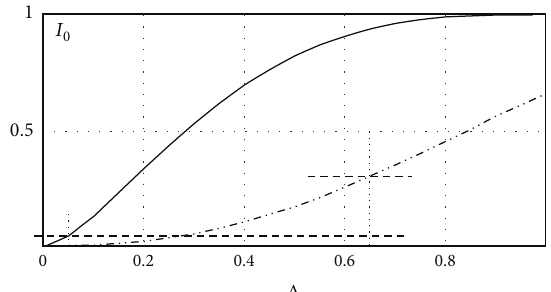
Figure 2: The focal spot size (FWHM) as a function of the annular aperture’s width ( Δ ) without (dashed line) and with (dashed-dotted line) a radial phase jump.